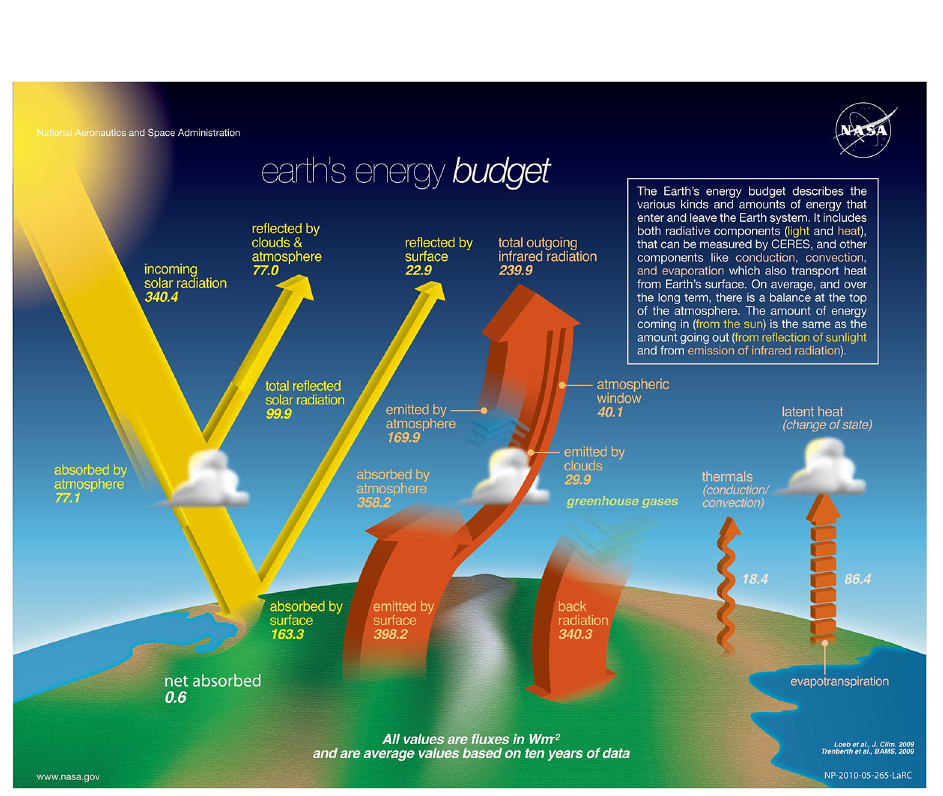
Fig. 1. – Earth’s energy budget. (Figure from NASA